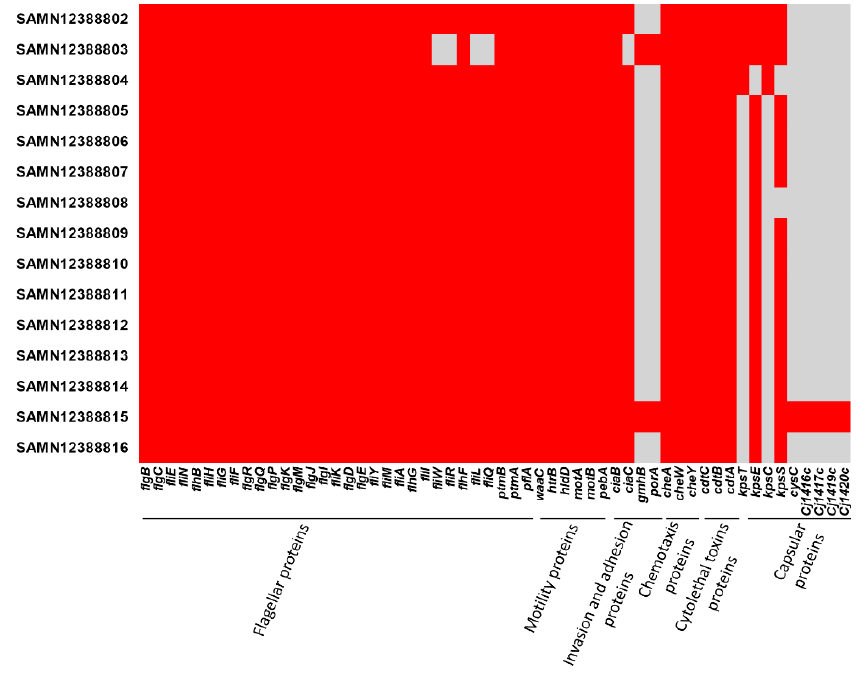
Figure 2. Virulence factors detected in the examined C. jejuni isolates in this study. Red color refers to presence of the protein and grey color refers to absence of the protein.